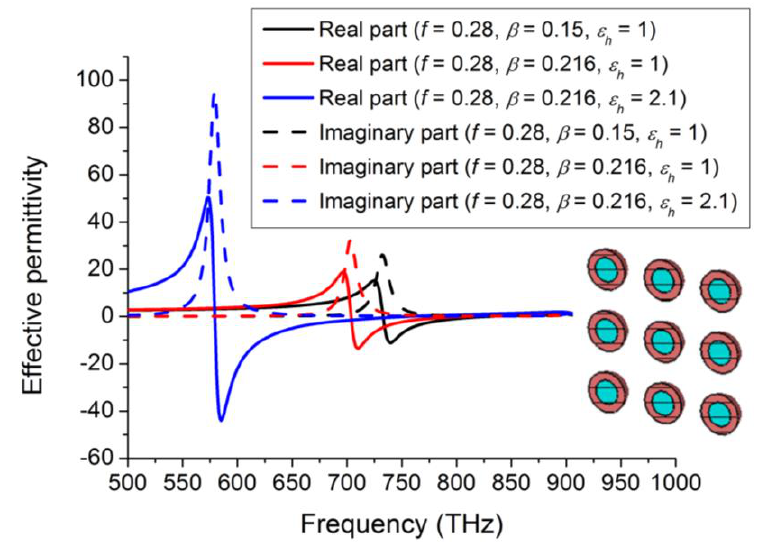
Figure 2. Effective relative permittivity of different arrays of core-shell NPs composed by a silver shell and a silica core embedded in a dielectric matrix with permittivity ε h . Please note that the last example refers to an array of core-shell NPs in a silica matrix ( ε h = 2.137).